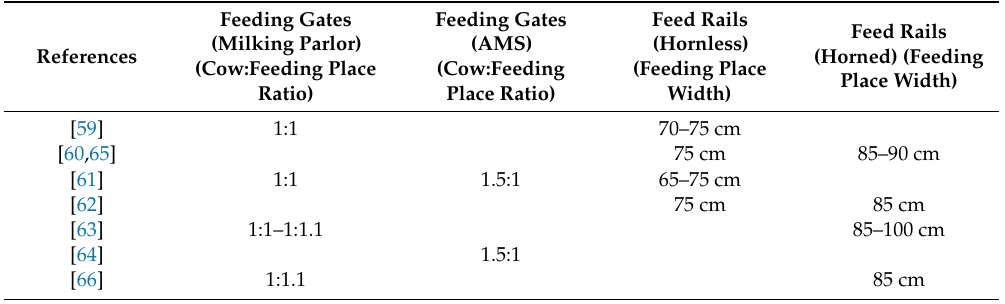
Table A4. Feeding places—recommendations for herds with a milking parlor or automatic milking system (AMS) and with horned or hornless